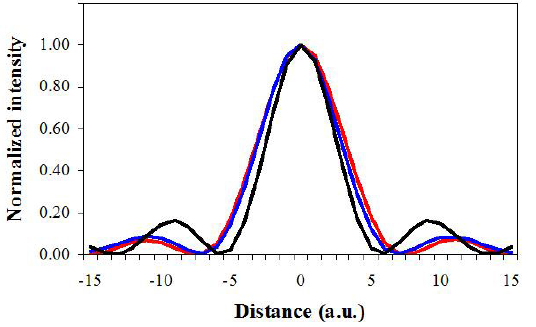
Figure 7. Cross sections through the PSFs for optimum combinations of SA (red), axicon (blue), and SA+axicon (black) in Figure 5.